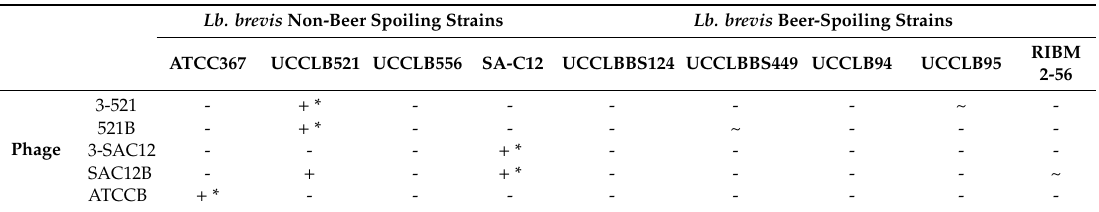
Table 2. Lb. brevis phage host range